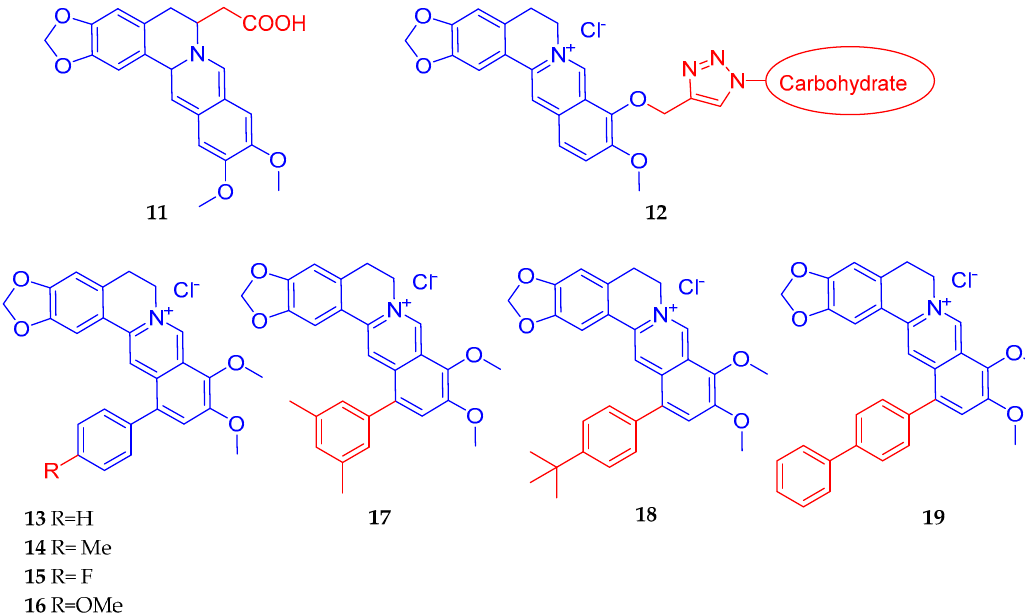
Figure 4. Berberine derivatives with potential antidiabetic effects [105–107].